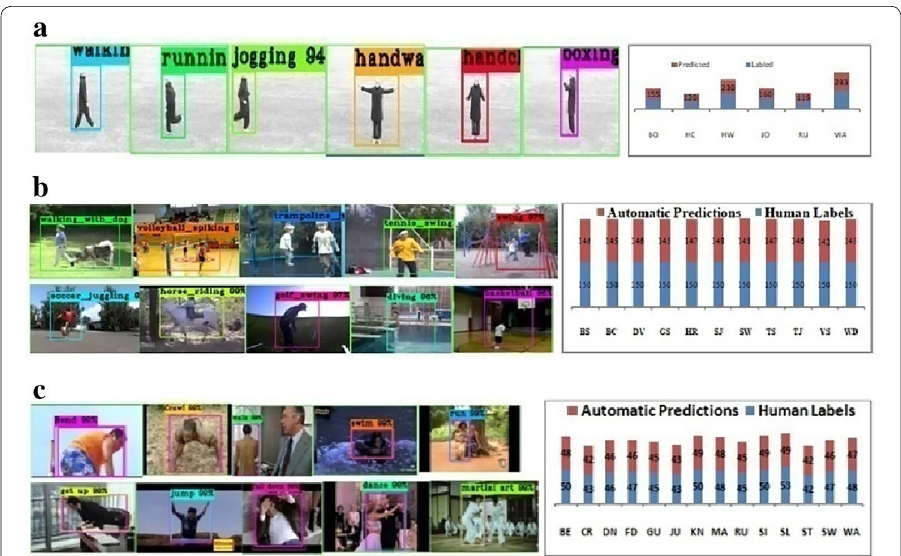
Fig. 12 Automatic visual predictions of human actions with confidence score from different datasets, a KTH; b UCF-11; c AVA